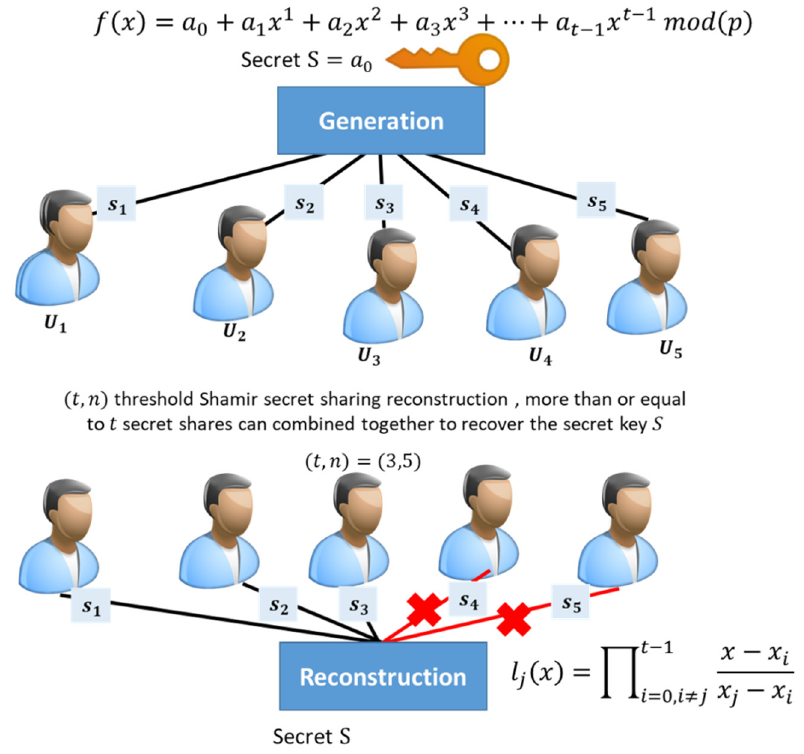
Figure 1. The threshold Shamir secret sharing key generation and reconstruction.